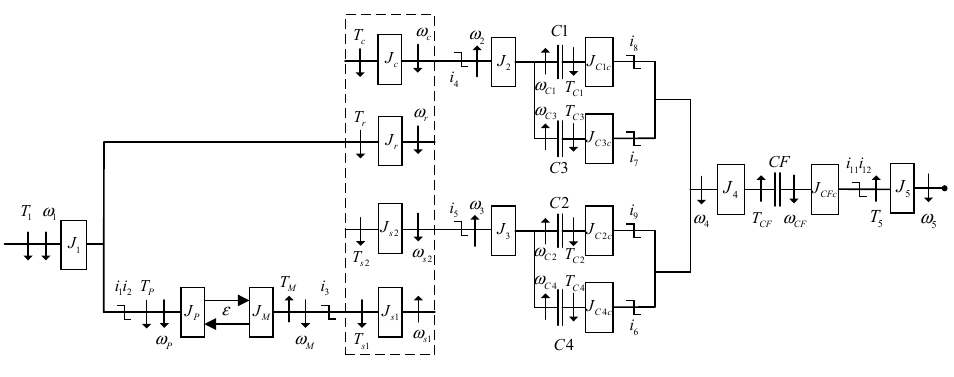
Figure 2. Rotational dynamics of HMCVT.